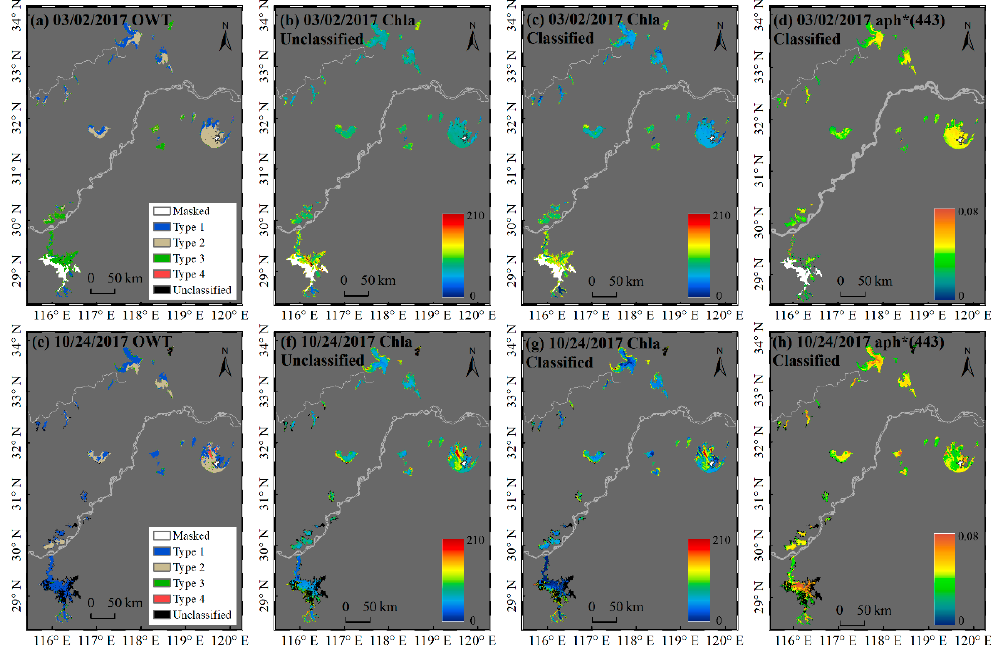
Figure 8. ( a ) Optical water types, ( b ) Chl a derived using the unclassified Mer-3B Chl a model, ( c ) Chl a derived using the class-specific Mer-3B Chl a model, and ( d ) a * ph (443) derived using the class-specific model on the 2 March 2017, OLCI image over the lakes in the LYHR Basin. ( e ) Optical water types, ( f ) Chl a derived using the unclassified Mer-3B Chl a model, ( g ) Chl a derived using the class-specific Mer-3B Chl a model, and ( h ) a * ph (443) derived using the class-specific model on the 24 October 2017, OLCI image over the lakes in the LYHR Basin.